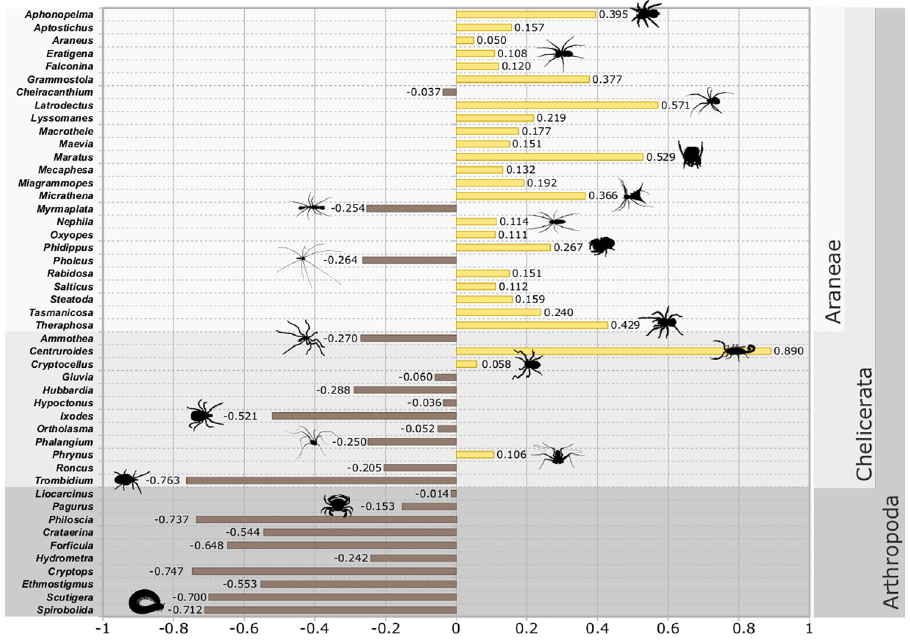
Fig 2. The difference between the mean fear score and mean disgust score for each examined stimulus. Notice that the vast majority of spider stimuli have higher mean fear score than disgust score (yellow bars, right side of the figure) while the vast majority of other chelicerates and other arthropods have higher mean disgust score than fear score (brown bars, left side of the